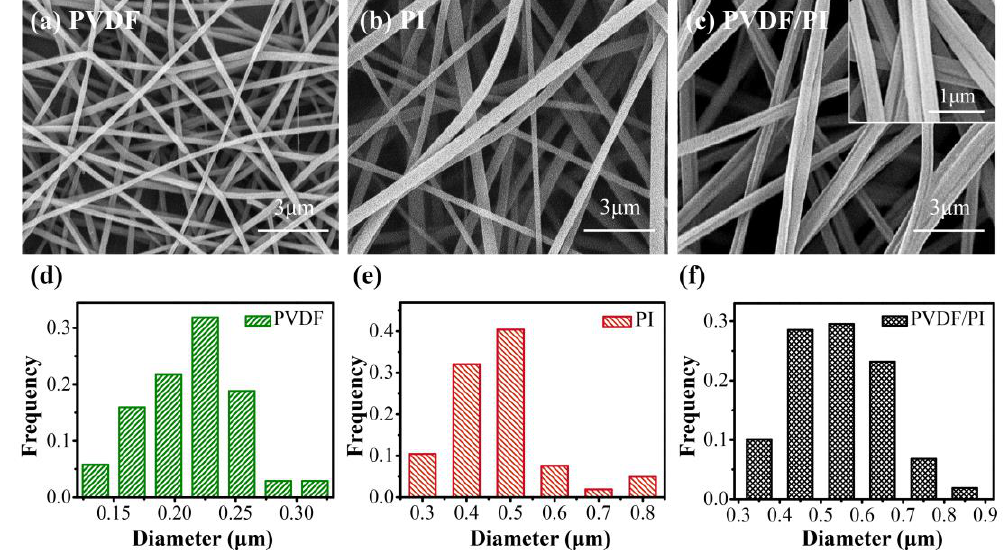
Figure 2. SEM images of PVDF ( a ), PI ( b ), and PVDF/PI ( c ) nanofibers; Fibers diameter distribution images of PVDF ( d ), PI ( e ) and PVDF/PI ( f ).